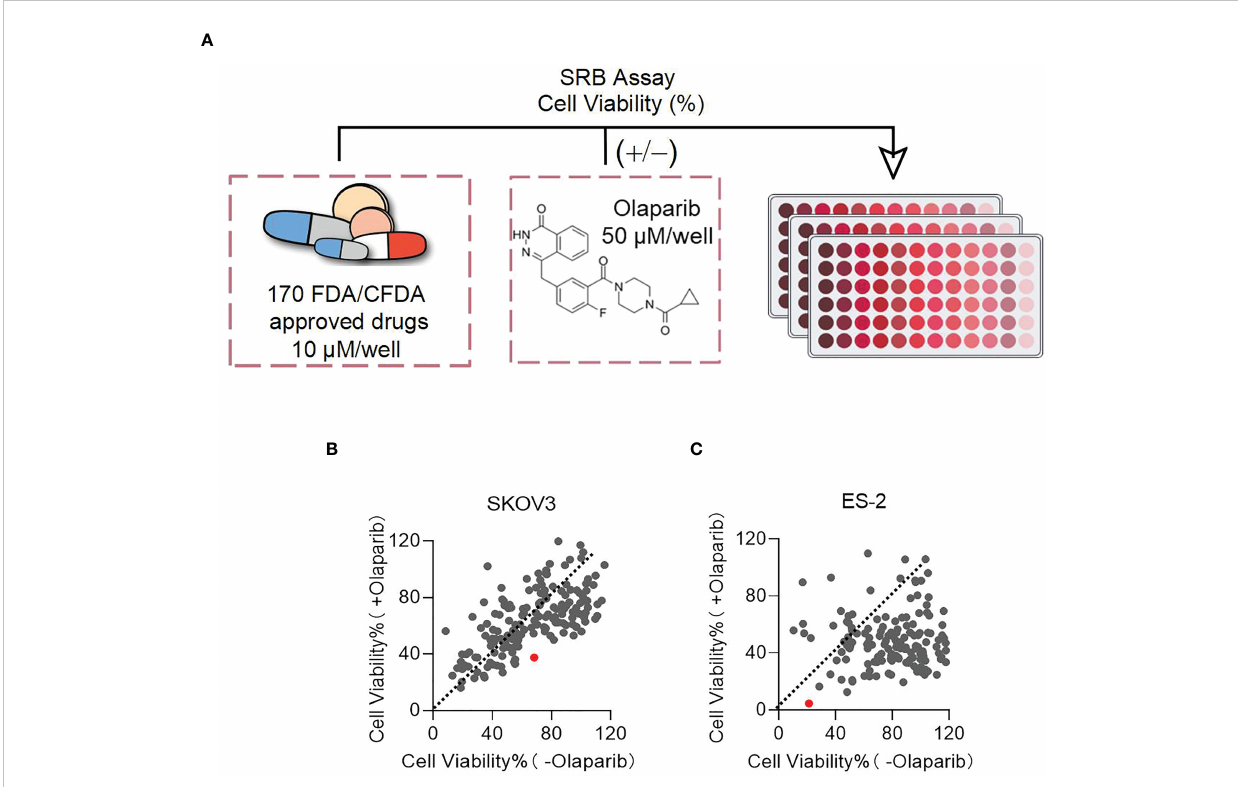
FIGURE 1 Disul fi ram is identi fi ed as a target drug to test in combination with PARPis. (A) Scheme of the sulforhodamine B (SRB) screening. Plots of cell viability of Disul fi ram with Olaparib vs without Olaparib in SKOV3 (B) and ES-2 cells (C) . The dashed line in each fi gure represents a slope of 1. Each dot represents a compound: red dots represent Disul fi ram. Cell viability was determined as described in the Methods